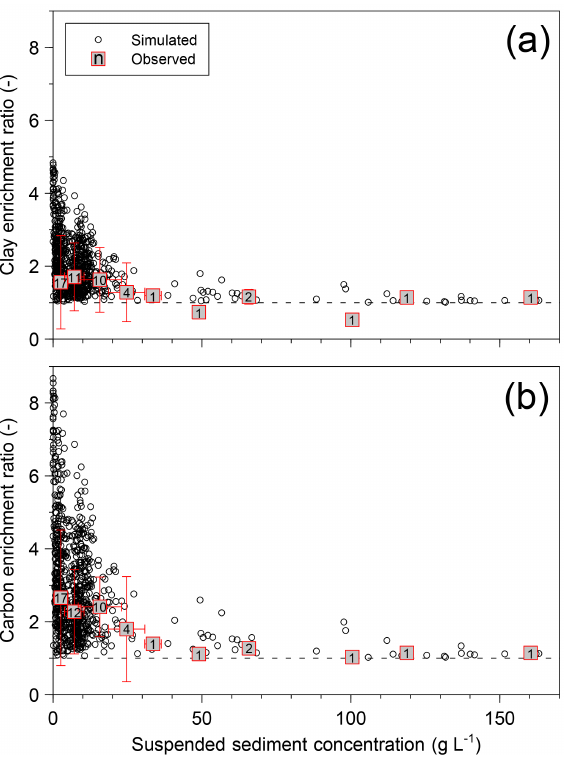
Figure 5. Clay (a) and carbon (b) enrichment ratios with respect to simulated and observed (Wang et al., 2010) suspended sedi- ment concentrations (observed n = clay 50 / carbon 49). Error bars of measurements represent the 95% confidence